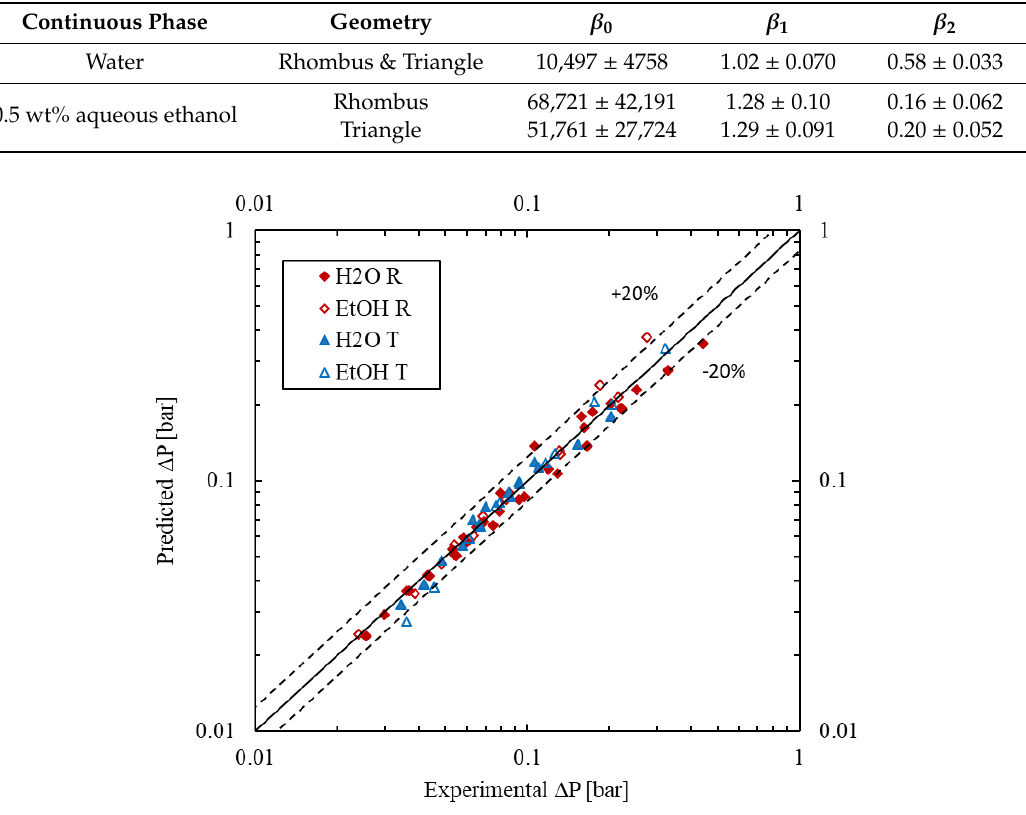
Figure 9. Parity plot of predicted vs. measured pressure drop values.